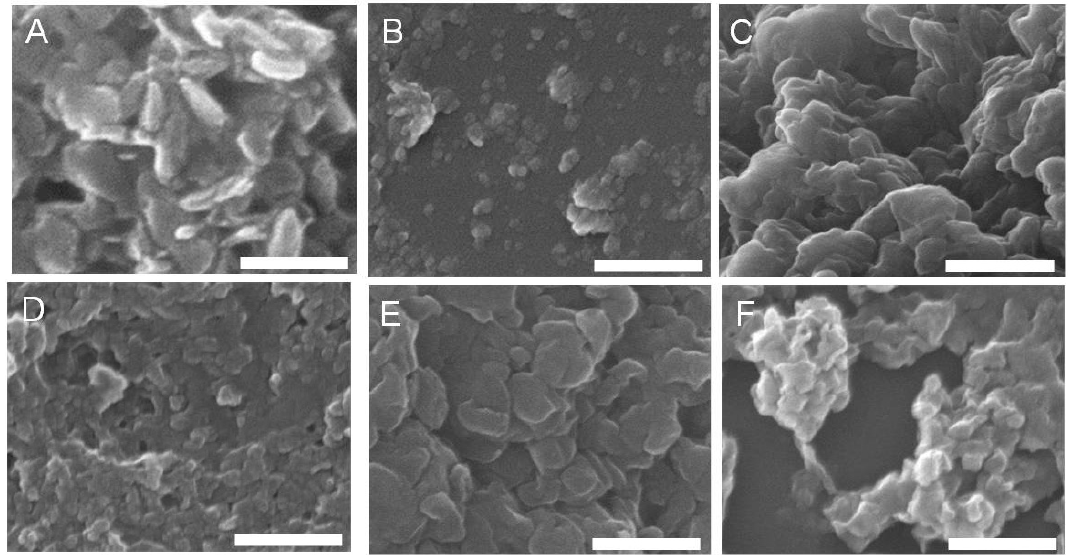
Figure 1. TEM images of LDH–NAP–HT ( A ); LDH–NAP–FP ( B ); LDH–DIC–HT ( C ); LDH–DIC–FP ( D ); LDH–IBU–HT ( E ); and LDH–IBU–FP ( F ). Scale bar: 500